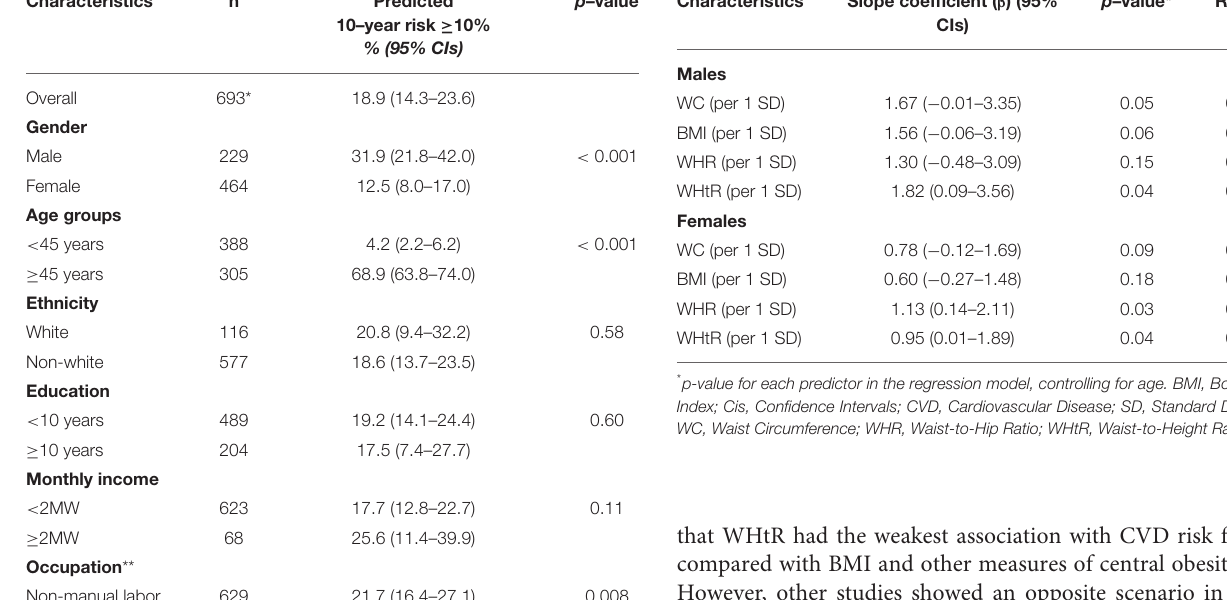
TABLE 3 | Association between 1 SD increase in anthropometric markers and CVD risk, using the Framingham Risk Score, age adjusted.